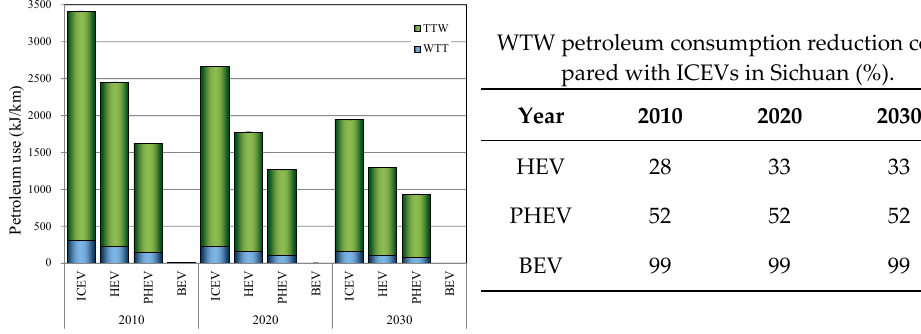
Figure 6. WTW petroleum consumption of ICEVs/HEVs/PHEVs/BEVs in Sichuan. From the prospective of time, the petroleum consumption for ICEVs/HEVs/PHEVs/BEVs continues declining from 2010 to 2030, due to improved oil extraction efficiency and strengthened fuel consumption standard. In 2010, the petroleum consumption for ICEVs and HEVs are 3410 kJ/km and 2450 kJ/km, which would decrease to 1950 kJ/km and 1300 kJ/km by 2030, respectively, with decrement rates of 43% and 47%. The petroleum consumption for PHEV and BEV in 2030 could further decrease by 42% and 80%, respectively, compared with the petroleum use in 2010. From the prospective of region, there is no significant difference among the two re- gions in WTW petroleum consumption results for ICEVs/HEVs/PHEVs/BEVs. The re- sults in the two regions show the same trends with the national results. BEVs are con- sidered the best option to solve the oil crisis, as they can significantly reduce the petro- leum consumption in either region.